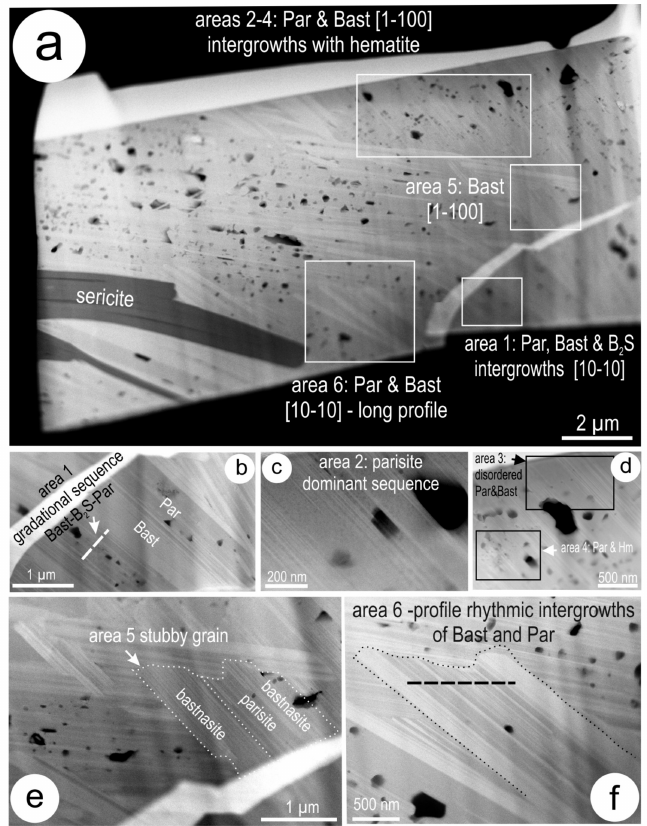
Figure 3. Low-magnification high angle annular dark field-scanning transmission electron microscopy (HAADF STEM) images of Foil 2 in ( a ) and the areas of interest representing study cases as marked ( b – f ); The zone axis to which the specimen was tilted for HAADF STEM imaging is marked in ( a ); Bast—bastnäsite; Hm—hematite;